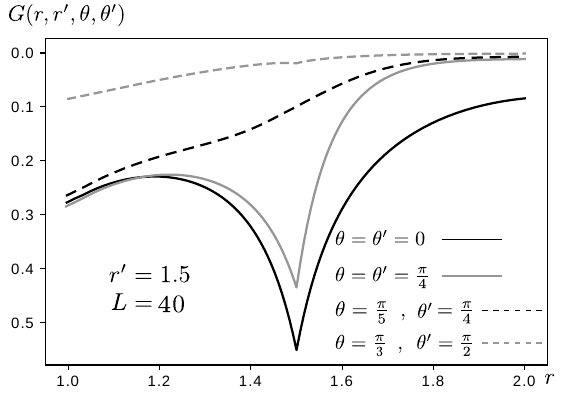
Figure 6. Solution to G ( r , r (cid:48) ) with DBC, as given in example 3 for different values. We set h = 1 We made L = 15 in the left plot and L = 30 in the right one.